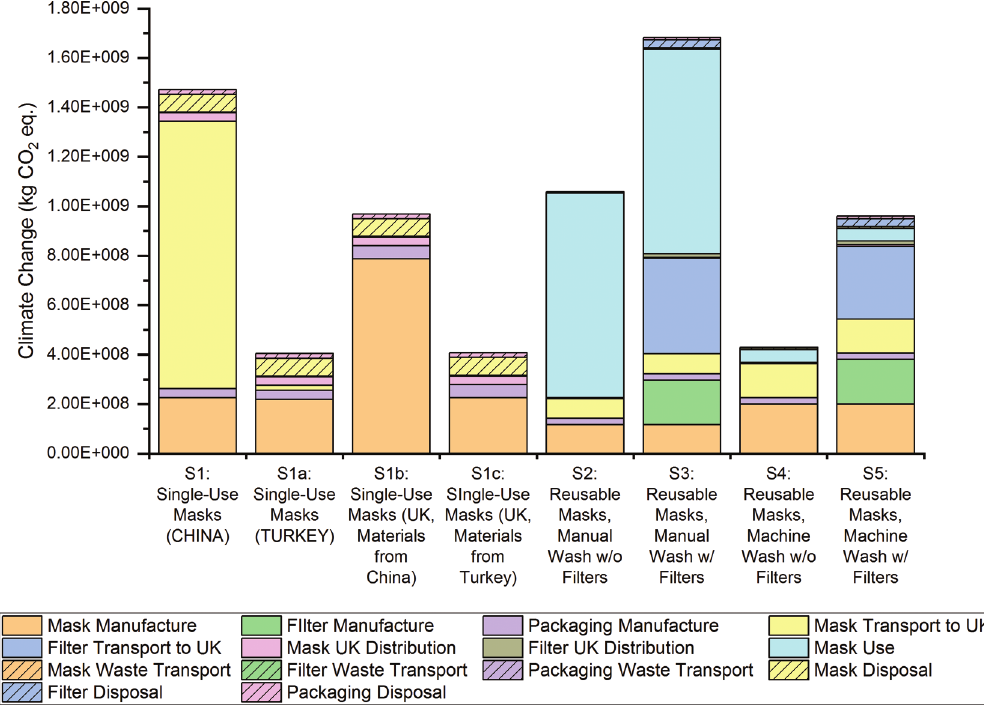
Climate Change results generated for each scenario of face mask use and single-use face mask